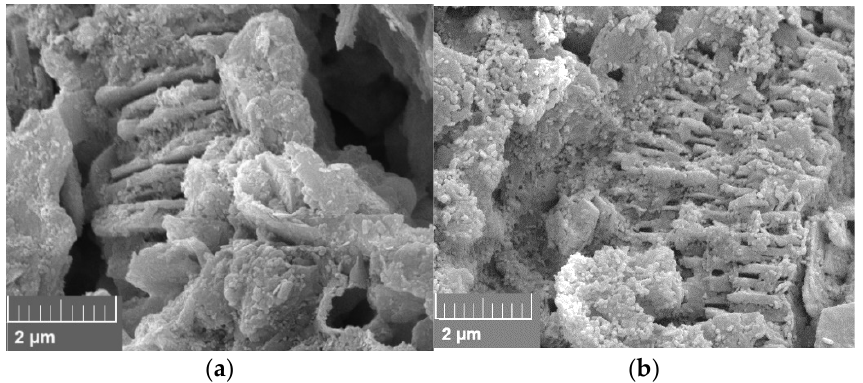
Figure 21. Scanning electron microscope (SEM) images measured for the core material used in this work. Comparison between NF B in formation water ( a ) and test water ( b ) on kaolinite structures found in Keuper rock. The sample treated with NF B in TW shows slightly higher adsorption of nanomaterials (( a ): Vacuum saturation of 1 wt% NF B in FW, Keuper; ( b ): Vacuum saturation of 1 wt% NF B in TW,